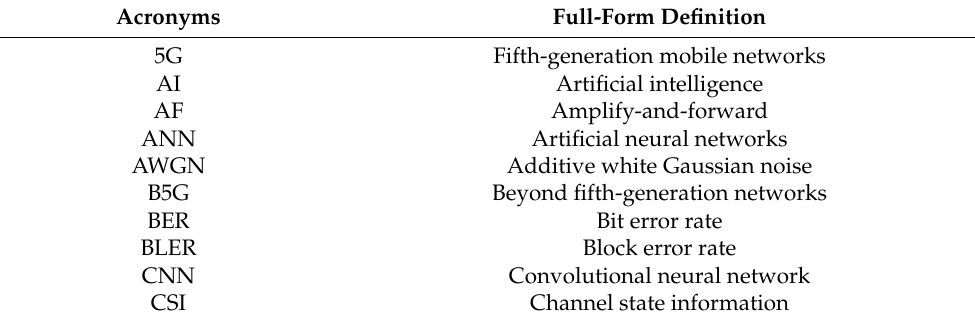
Table 2. Abbreviations and their full form